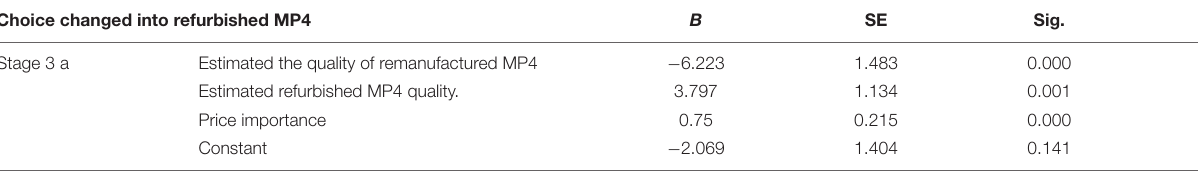
TABLE 6a | L 1 logit Regression Analysis (changes in purchase options for MP4). Choice changed into refurbished MP4